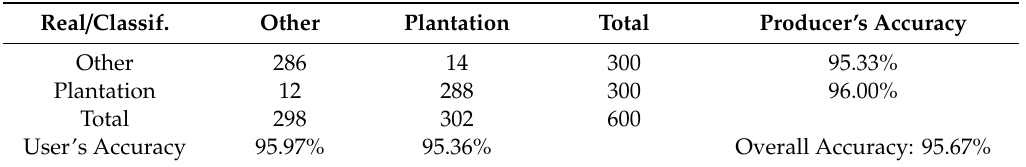
Table 5. Evaluation of chestnut plantation area predictions obtained using Model 2 (model created by applying Random Forest). Ground truth data were created with a random stratified sample of 600